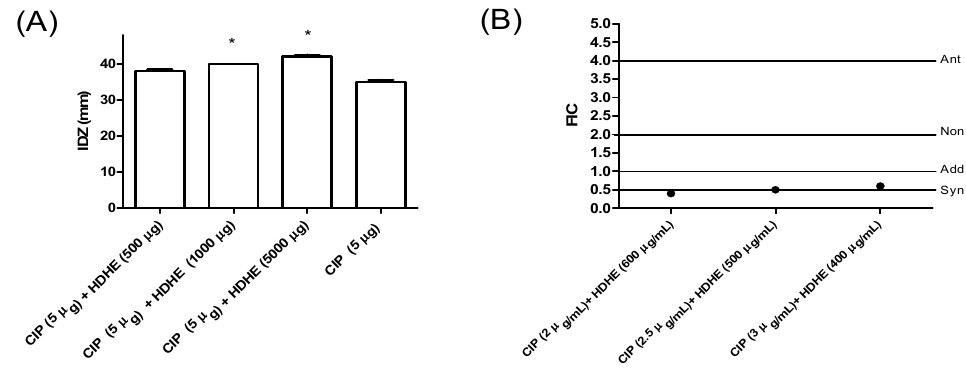
Figure 2. Combinatory effects of hydroalcoholic extract from leaves of Himatanthus. drasticus and ciprofloxacin against Klebsiella. pneumoniae evaluated by agar diffusion assay ( A ) and microdilution assay ( B ). HDHE: H. drasticus hydroalcoholic extract; CIP: ciprofloxacin; FIC: fractional inhibitory concentrations. * p < 0.05 in relation to ciprofloxacin disk. The tests were performed in two independent assay in quadruplicate.